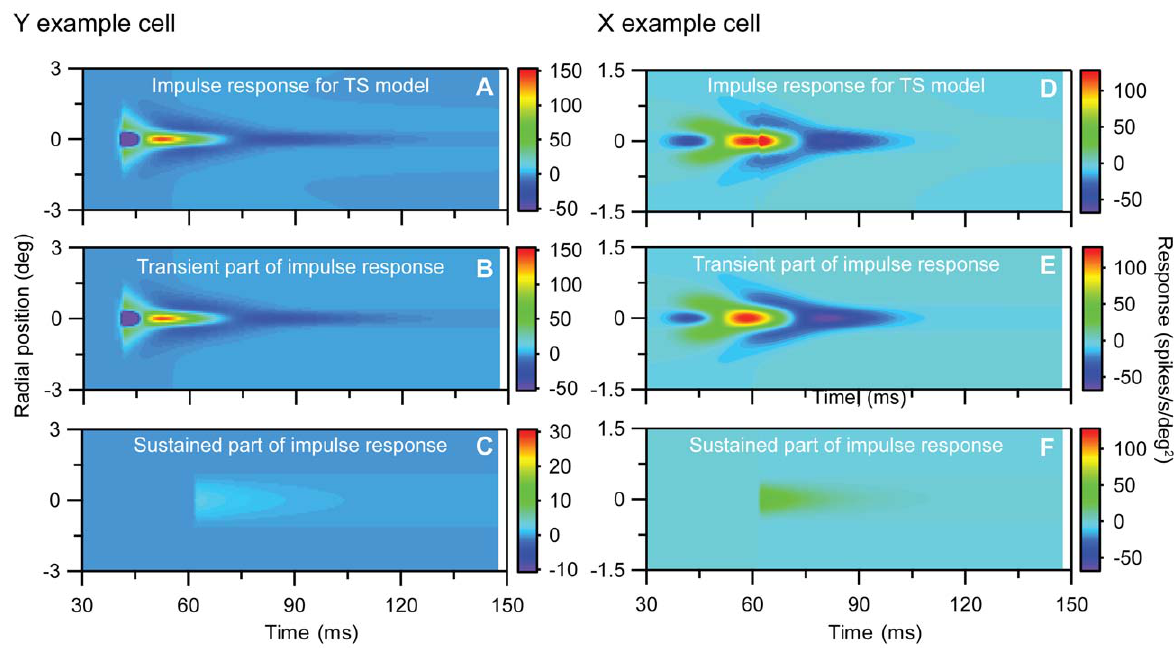
Figure 11. Predicted spatiotemporal impulse-response function D TS ( t,r ), cf. Eq.(16), for the transient-sustained (TS) model for example on-center Y and X neurons in Figs. 1 and 2. All model parameters correspond to the fit depicted in Fig. 10 and are listed in Table 1. A. Predicted impulse-response function for full TS-model for Y neuron. B. Contribution from transient part ( f t1 ( t ) g t1 ( r ) + f t2 ( t ) g t2 ( r )). C. Contribution from sustained part ( f s ( t ) g s ( r )). D – F. Same as (A)–(C) for the X-neuron. Notice that (i) the color scale in C and F differ from the scale in the other corresponding color maps and (ii) that the negative response for the Y-neuron has been truncated at the value 2 50 spikes/s/deg 2 in panels A and B.